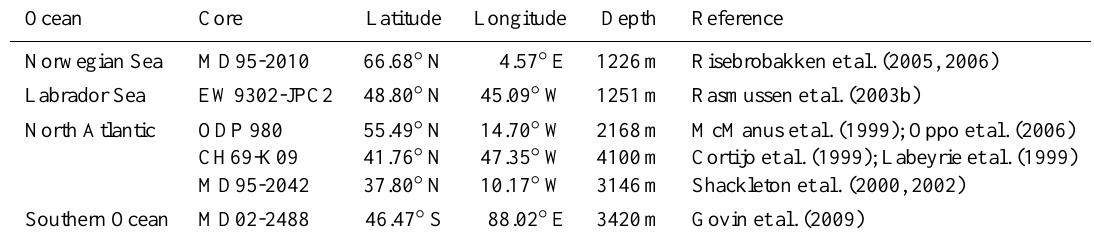
Table 1. Cores considered in this study (the location of cores from the North Atlantic, Labrador and Norwegian Seas is shown in Fig.